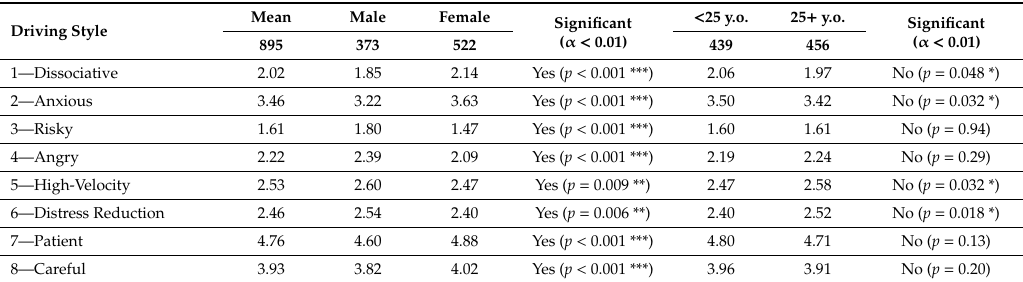
Table 7. Mean values of driving styles by gender and age (*** indicates α < 0.001; ** indicates α < 0.01; * indicates α < 0.1).